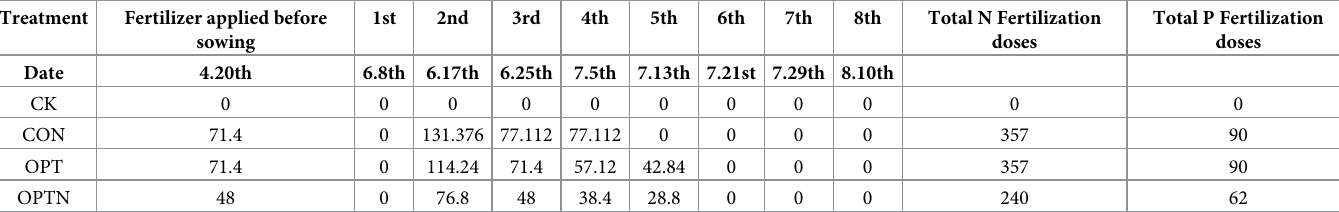
Table 1. Fertilizer doses applied per irrigation (kg � hm -2 ). Treatment Fertilizer applied before